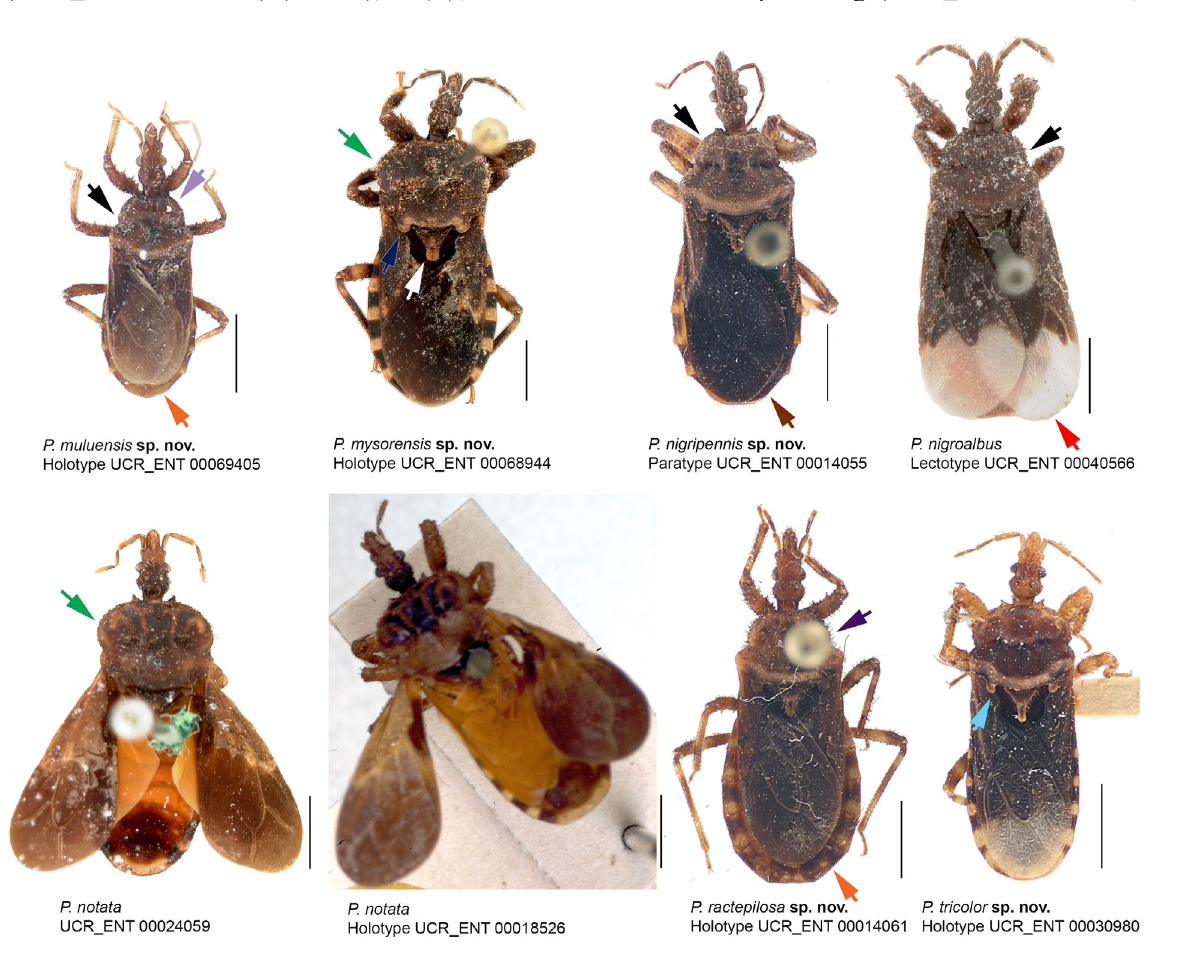
Fig. 15. Dorsal habitus images for species of Physoderes Westwood, 1845 (partial). For an explanation of the colored arrows, see key on page 66. Scale bars = 2